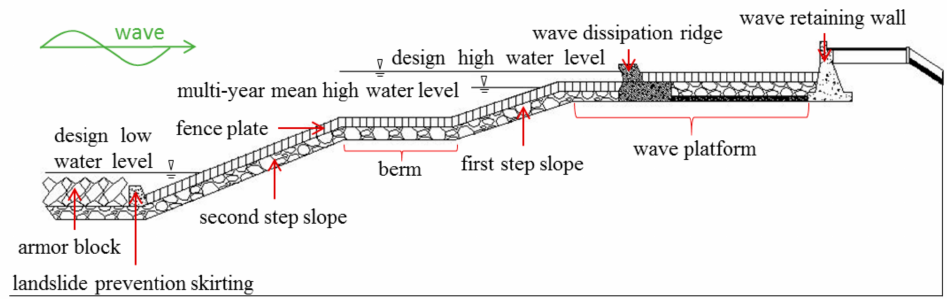
Figure 2. Scheme of the breakwater